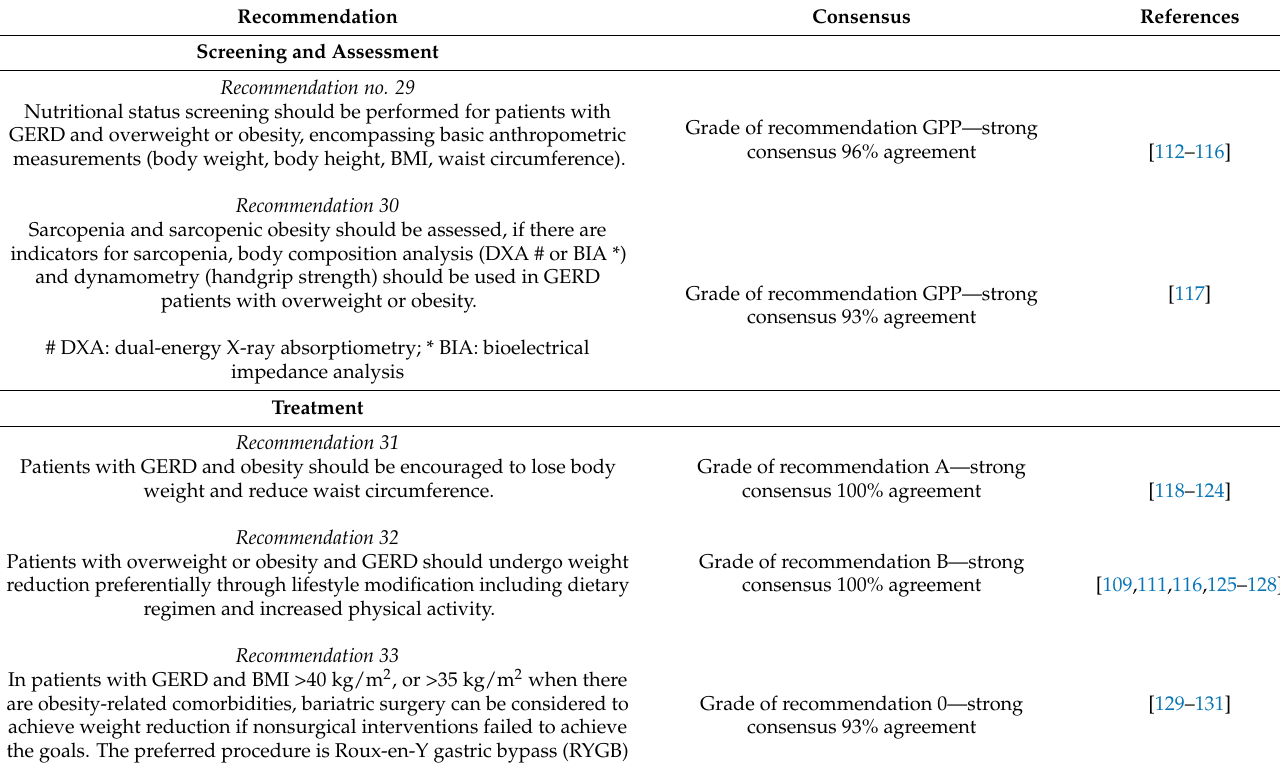
Table 5. Recommendations formulated by the European Union of Gastroenterology for patients with GERD and obesity